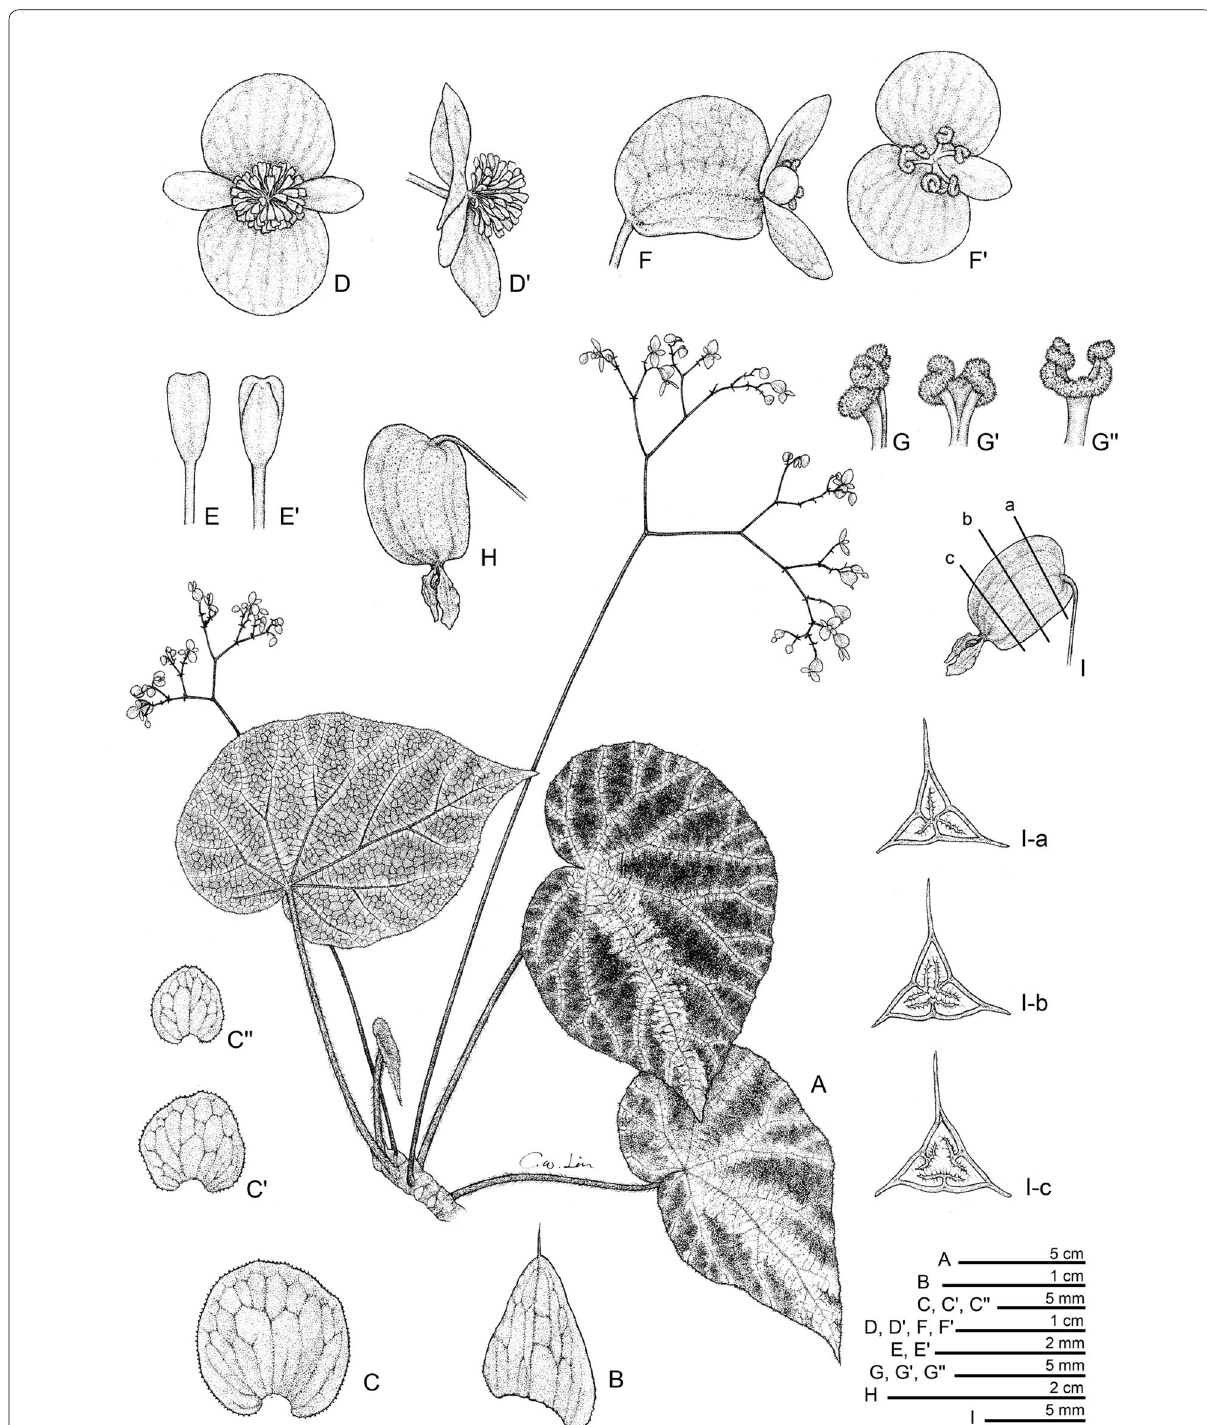
Fig. 5 Begonia larvata C.I Peng, Yan Liu & W.B.Xu. A Habit; B Stipule; C , C’ , C’’ Bracts, lower to upper; D, D’ Staminate flower, face view and side view; E, E’ Stamen, dorsal and ventral views; F , F’ Pistillate flower, side views, face view; G , G’ , G’’ Style and stigmatic band, side, dorsal and ventral views; H Capsule; IA – IC Serial cross section of an immature capsule. All from Peng et al . 24372